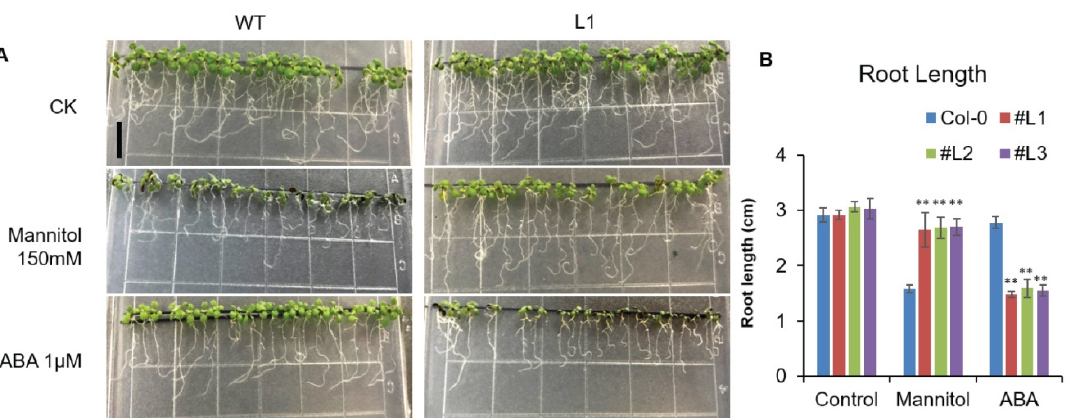
Figure 3. Root length observation of wild type (WT) and OsHSFA3 -overexpressing transgenic Arabidopsis plants with mannitol and abscisic acid (ABA) treatment. ( A ) Seedlings of wild type and OsHSFA3 transgenic lines grew on MS medium in control (CK), mannitol treatment (150 mM) and ABA treatment (1 μ M). ( B ) Statistical analysis of root length of wild type and OsHSFA3 -overexpressing Arabidopsis plants with and without mannitol and ABA treatment. Values indicate mean ± SE of 10 biologically independent samples. Significance of data is tested with Student’s t test. ** represents p < 0.01.